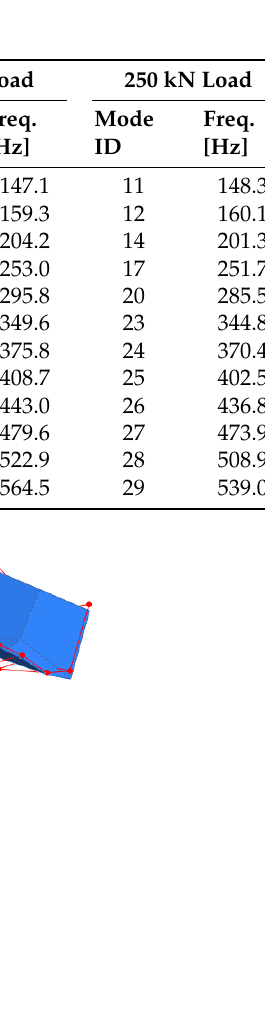
Figure 11. Example of a pair of initial and damaged modes for 40 kN